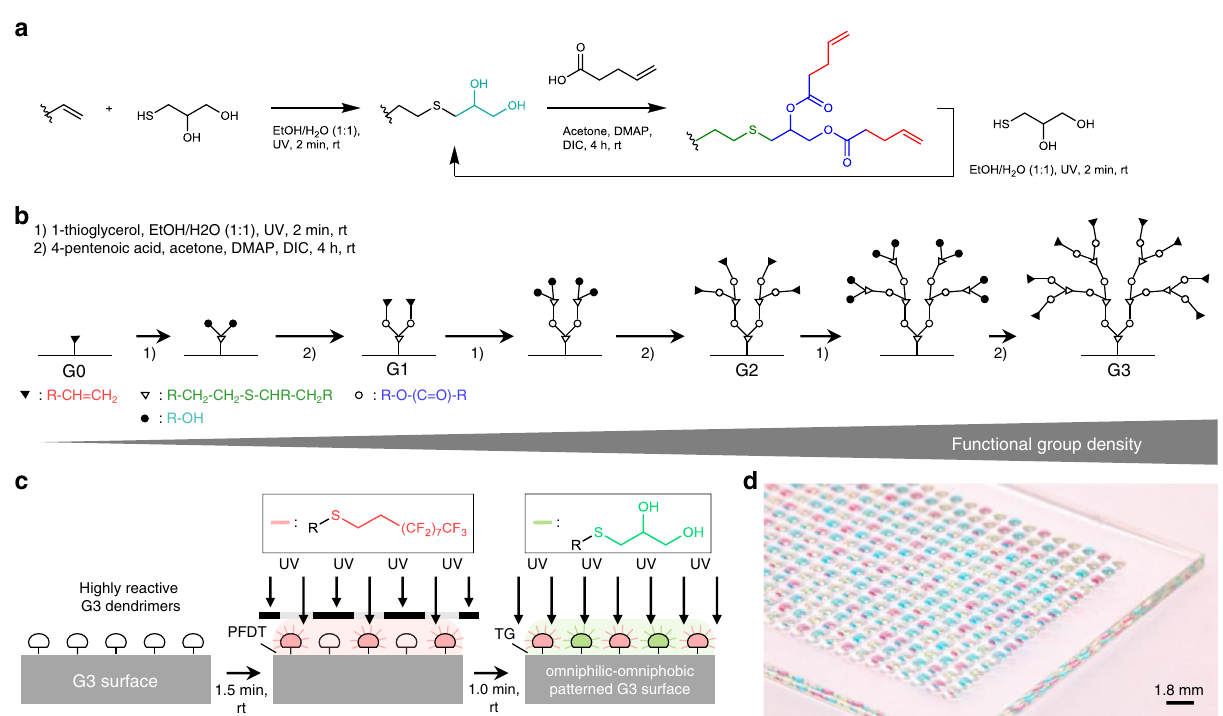
Fig. 2 Manufacturing of patterned dendrimer slides based on grafted poly(thioether) dendrimers. a The manufacture of dendrimeric slides begins with silanization of a glass slide with triethoxyvinylsilane, followed by a repetitive cycle involving a two-step reaction. An alkene reacts in a photochemical thiol- ene click reaction with 1-thioglycerol followed by an esteri fi cation with 4-pentenoic acid. b The amount of functional end-groups increases by 2 n ( n : amount of repetitions) for each dendrimer generation (G) with reaching 8 reactive groups for the G3 surface. c A highly reactive, alkene-presenting dendrimer surface is patterned using the photochemical thiol-ene reaction. Omniphobic borders (red) are generated by a reaction with per fl uorodecanethiol (PFDT), followed by the formation of omniphilic spots (green) by 1-thioglycerol (TG). d Photograph of a nanodroplet array of different compounds dissolved in dimethyl sulfoxide on an omniphilic – omniphobic patterned slide. Spot diameter: 900 µ m; omniphilic border width: 225 µ m; droplet volume: 100 nL; scale bar: 1.8